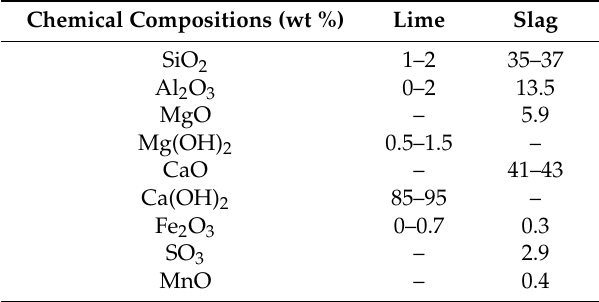
Table 2. Chemical compositions (in terms of oxides) of hydrated lime and lime-ground granulated blast furnace slag